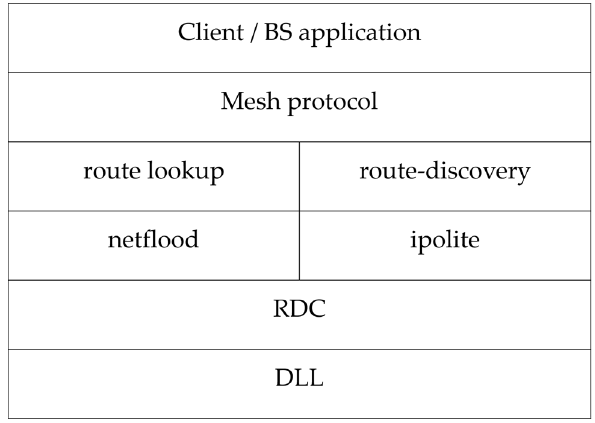
Figure 13. Network Stack.